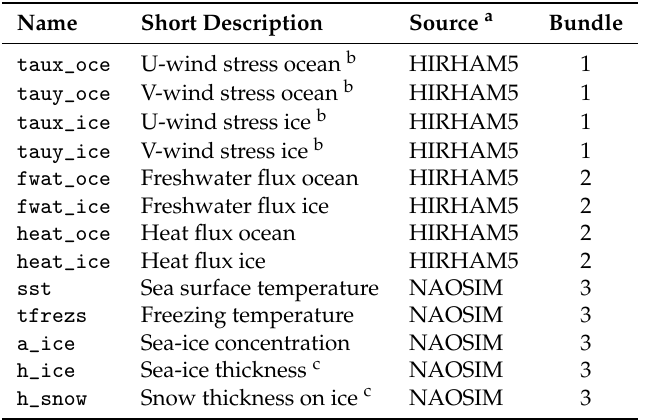
Table 1. List of the coupling fields between HIRHAM5 and NAOSIM.